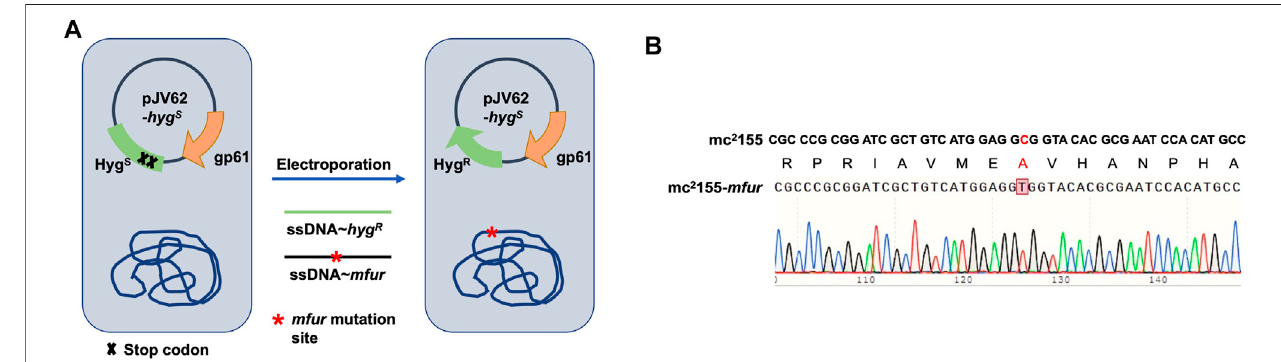
FIGURE5| GenerationofapointmutationfurA28Vinfuronthechromosomein M.smegmatis . (A) Strategiesforrecombineering.Thesite-directedmutagenesisof fur was obtained using Phage Che9c gp61-mediated recombination. Plasmids pJV62- hyg s express Che9c gene product gp61, to facilitate single-stranded DNA carryingthepointmutationrecombination.Theclonescarryingthemutatedsitewereselectedon7H9withHyg R andKan R . (B) Thesequencingresultofapointmutation in fur. Sanger sequencing showed the nuclear acid point mutation site c/t, resulting in the protein switch from A to V at site 28th.